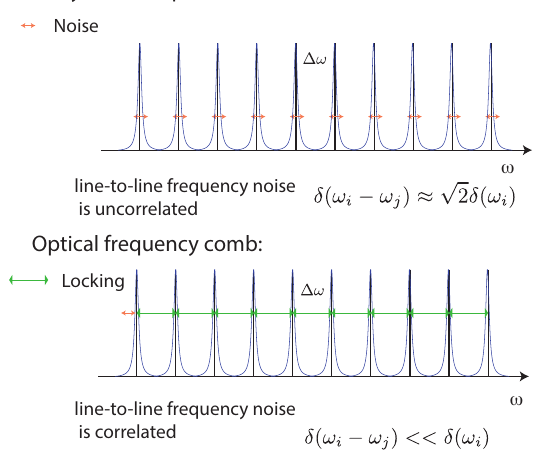
Figure 1: Schematic difference between an array of single mode lasers (top) and a frequency comb